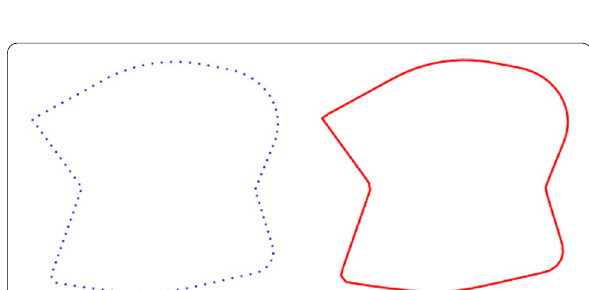
Fig. 7 Layer boundary tool path generated from the layer coordinates points in example (2). The proposed algorithm can generate contour tool-paths to fabricate the area along the boundary of every AM-sliced layer. This can scale back surface errors and improve the geometrical quality of